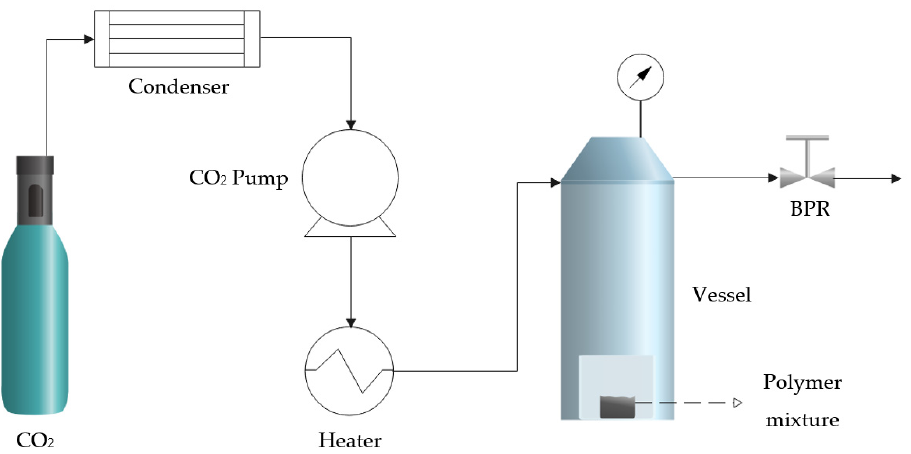
Figure 1. Flow diagram of the supercritical foaming equipment.